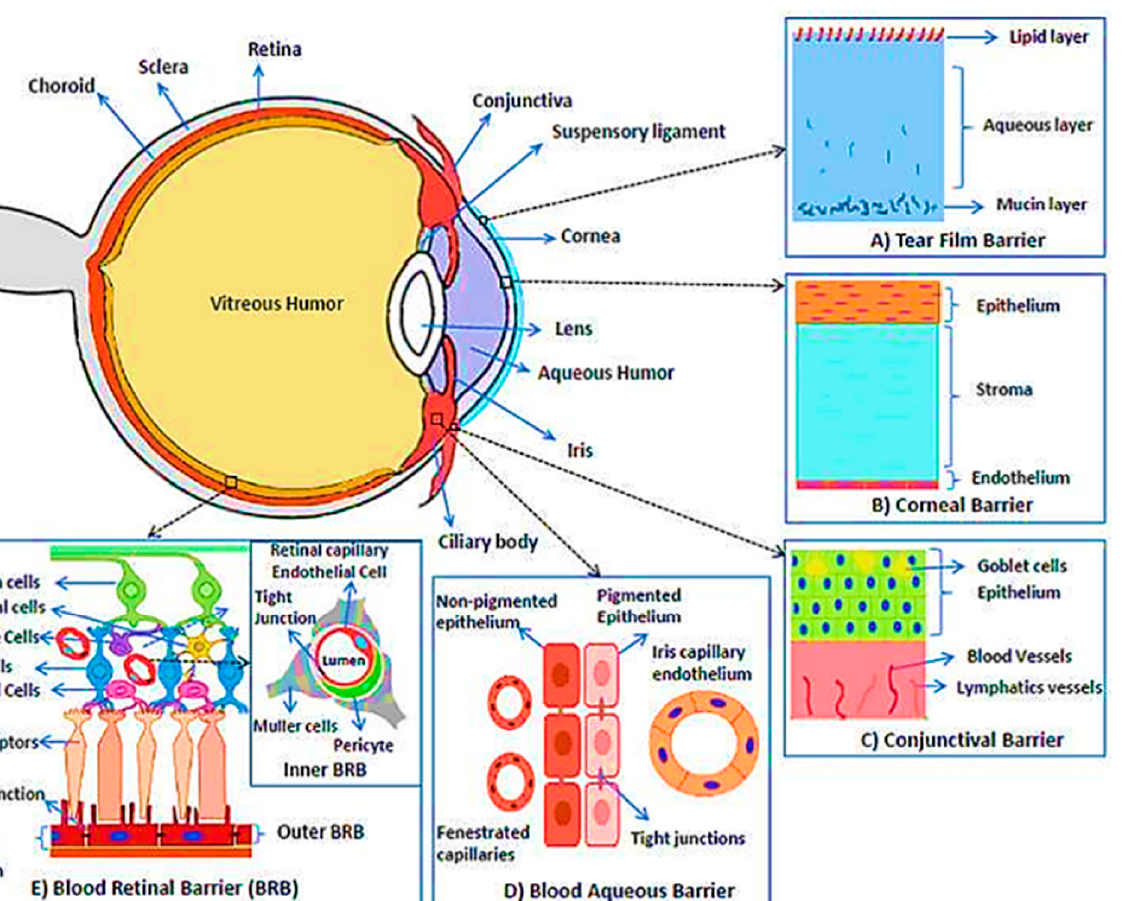
Figure 1. Structure of the eye and di ff erent barriers for drug delivery. ( A ) Tear fi lm barrier. ( B ) Corneal barrier. ( C ) Conjunctival barrier. ( D ) Blood-aqueous barrier. ( E ) Blood-retinal barrier (BRB). Reprinted with permission from reference [12]. Copyright 2017 Elsevier.